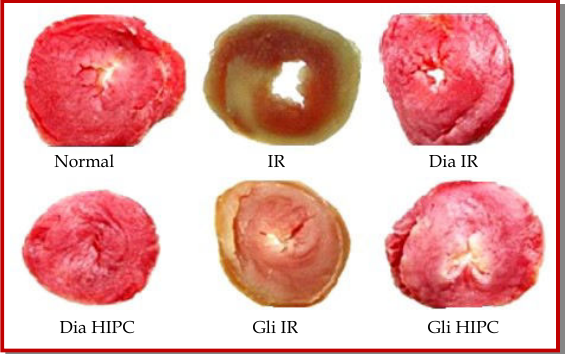
Figure 2: Infarct size measurement in heart using triphenylte- trazolium chloride (TTC) staining in different conditions